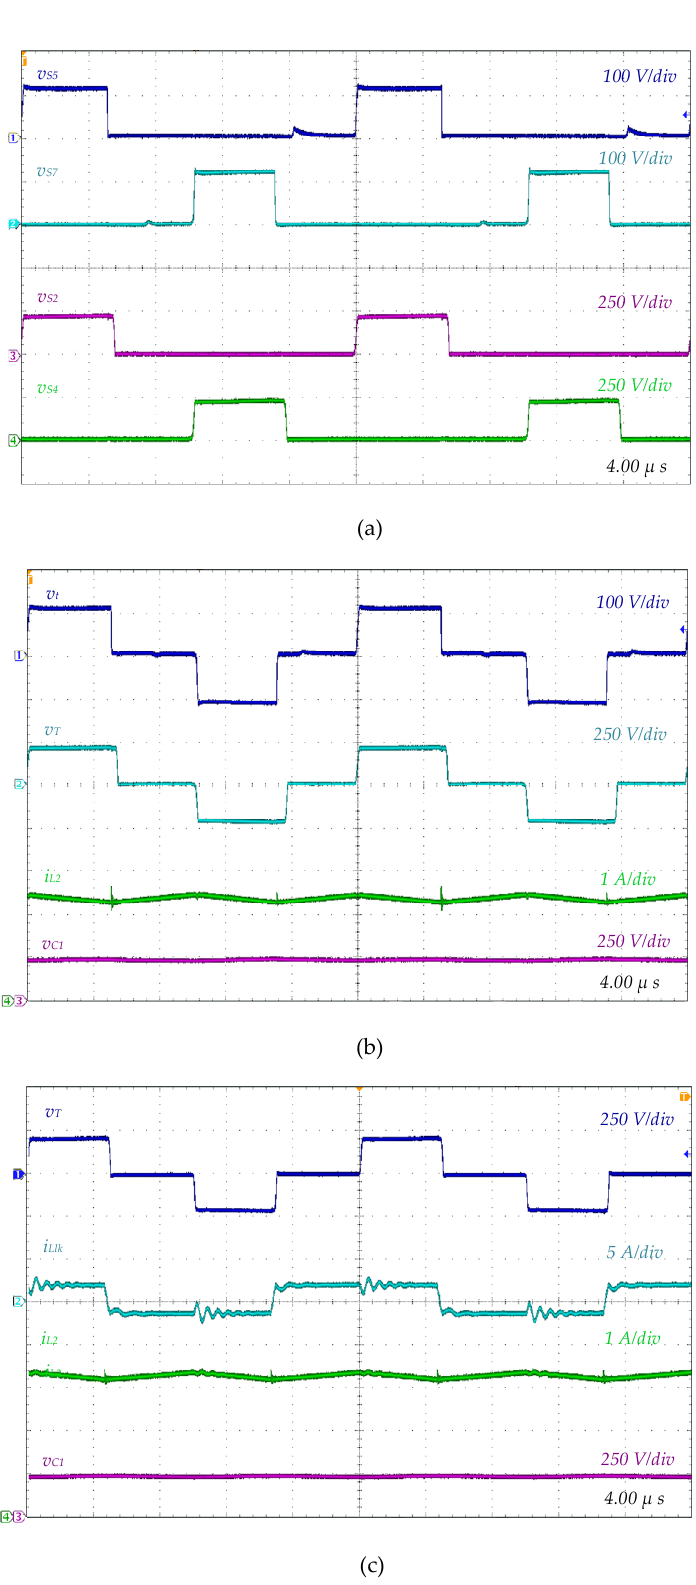
Figure 18. Steady-state operation of the converter operating in step-up mode: ( a ) Semiconductors’ voltages, transformer voltages ( v T , v t ), current ( i Llk ), voltage ( v C1 ), and current ripple in the filters ( i L2 ) ( b ) for a power equal to 100 W , ( c ) for a power equal to 200 W .